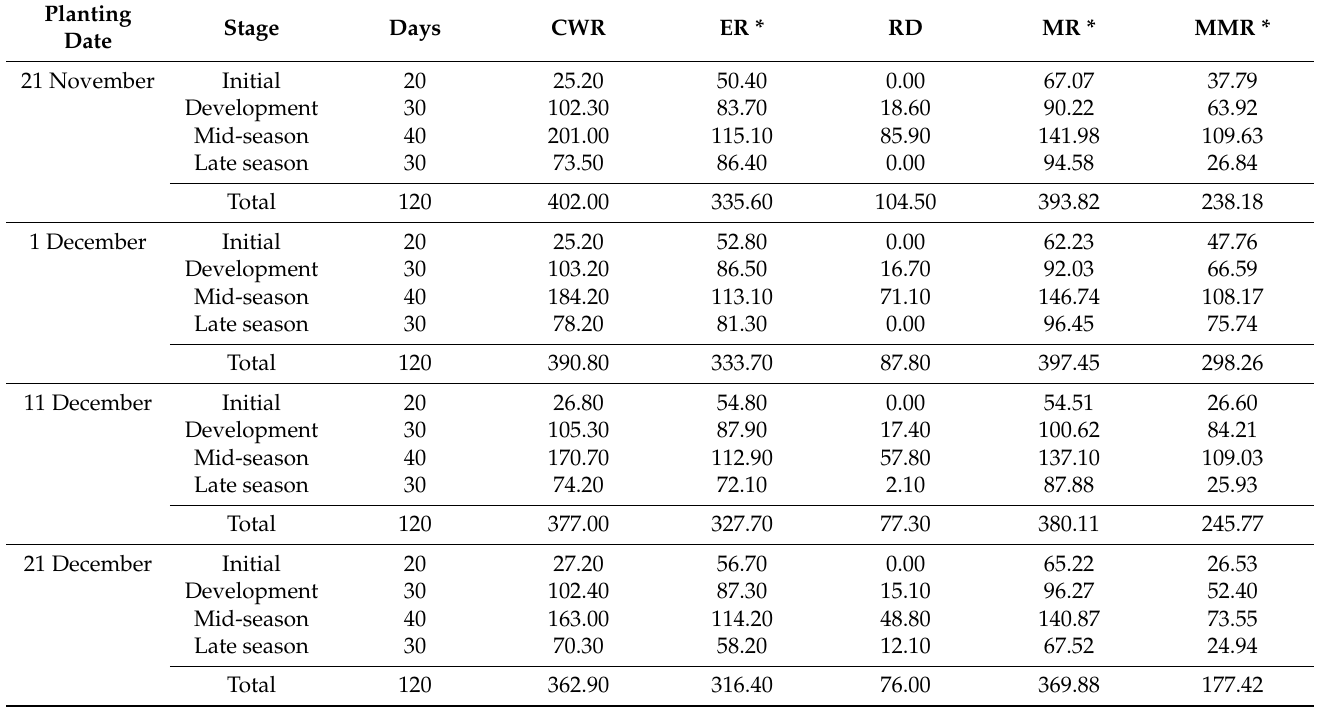
Table 2. CWR when planting is on 21